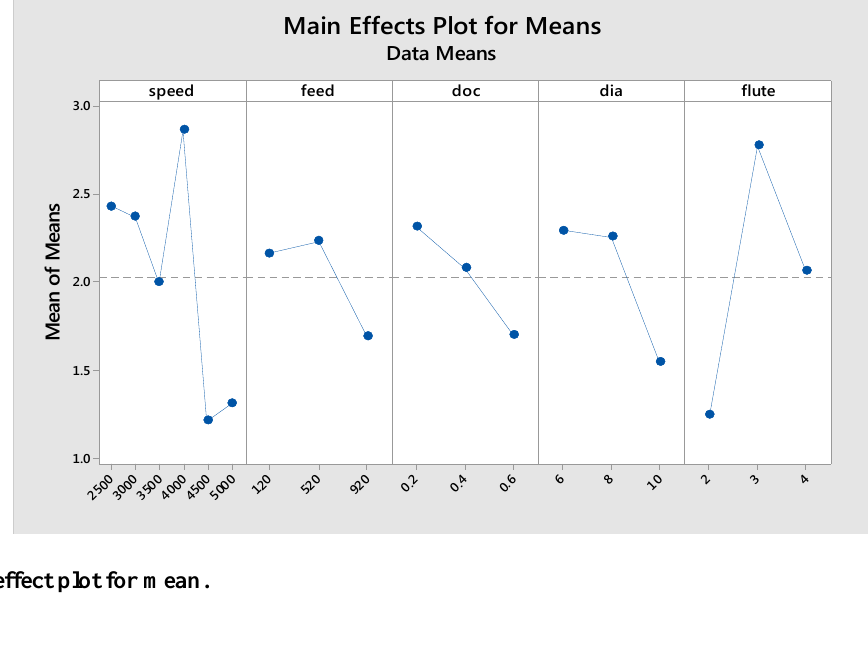
Fig. 7.a. Main effect plot for mean.